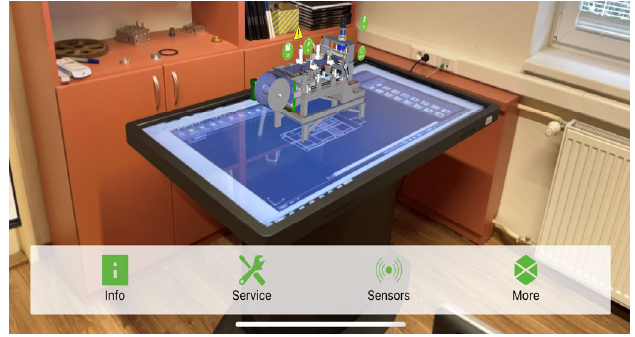
Figure 6. Visualization of a 3D model using drawing documentation.